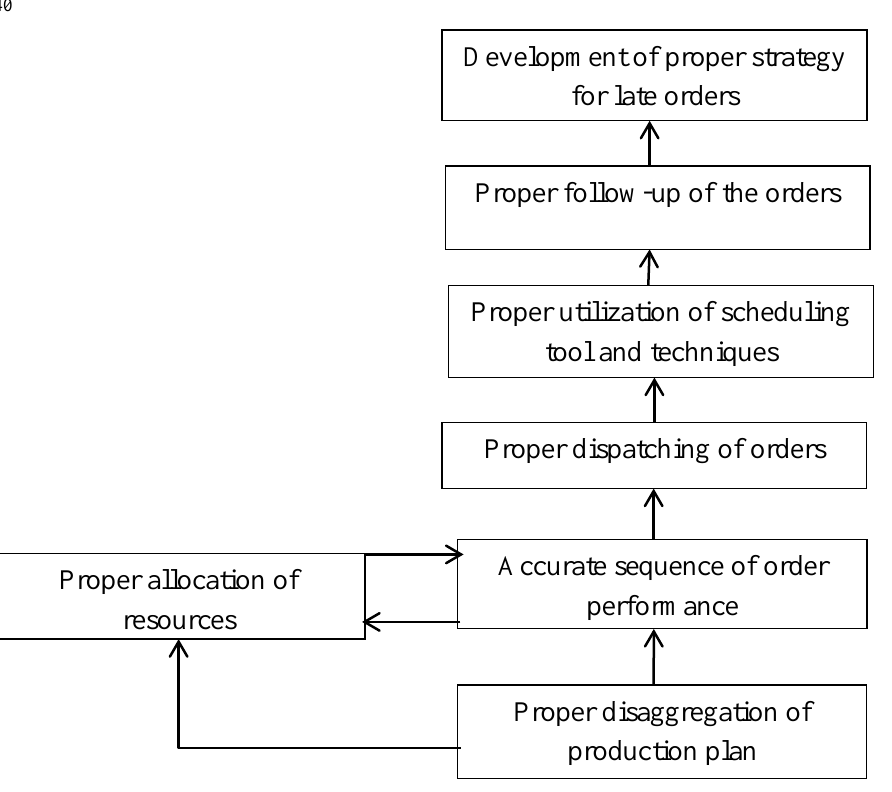
Fig. 4. Interpretive structural model showing levels of factors